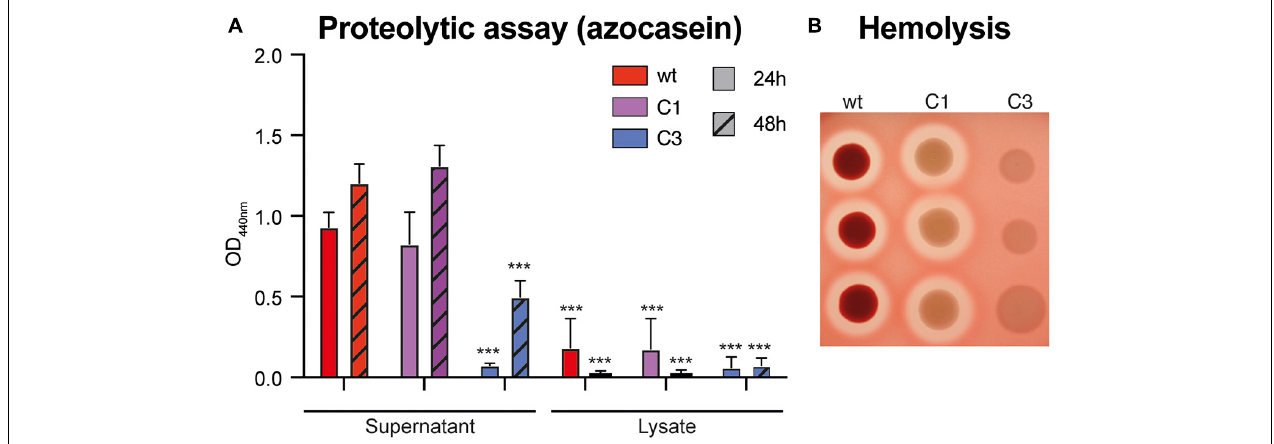
FIGURE 3 | Proteolytic and hemolytic activity of S. marcescens VA. (A) Proteolytic activity of wt, C1 and C3 S. marcescens VA extracts. Tests were performed using an azocasein colorimetric assay on extracts coming from cultured incubation for 24 or 48 h. Data show the average ± SEM of three independent replicates. *** p < 0.001. (B) Hemolytic activity on blood-agar containing human red-blood cells. The picture shows the result of one representative experiment with three technical replicates for each strain. Three independent replicates were